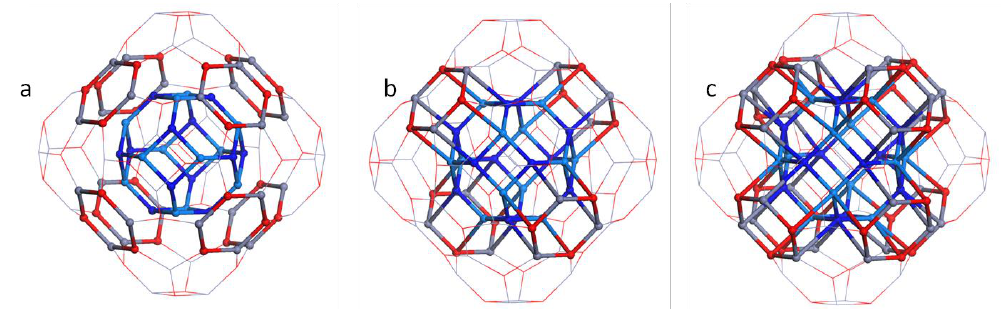
Figure 3. Models of the n = 60 T double bubble, with inter-layer links between the inner h n = 12 sodalite cage and the eight hexagonal rings that are in the centres of the octahedron faces of the outer n = 48 bubble, highlighted using ball-and-sticks rather than line representation for: ( a ) no bridging links; ( b ) four bridging links; and ( c ) all eight bridging